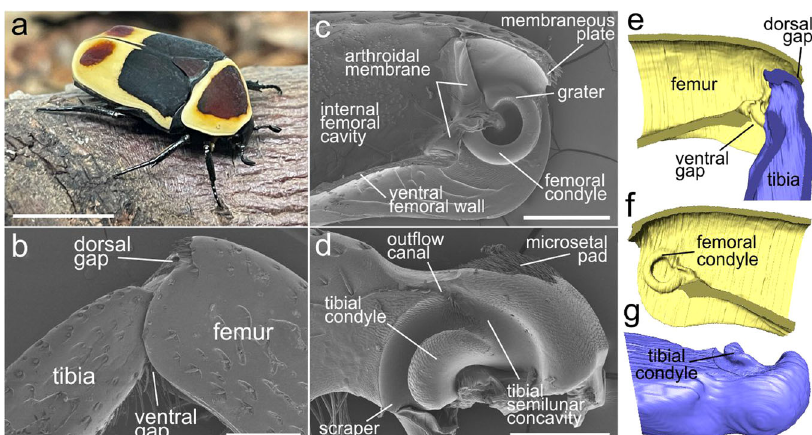
Fig. 1 Pachnoda marginata beetle and the structure of the femoro-tibial joint of the foreleg. a P. marginata ; b – d SEM micrographs: b femoro-tibial joint, lateral view; c femoral counterpart, sagittal section; d tibial counterpart, lateral view; e – g micro-CT volume reconstructions: e femoro-tibial joint, sagittal section; f femoral counterpart, sagittal section; g tibial counterpart, anterolateral view. Scale bars: a 1 cm, b , c 500 µ m, d 300